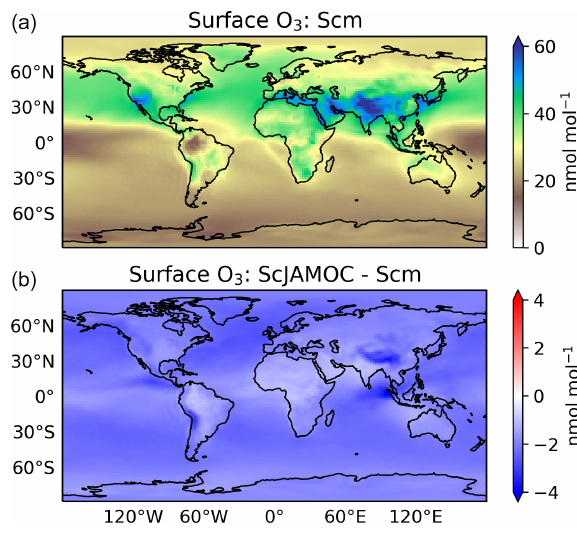
Figure 9. Mean surface O 3 mixing ratios for Scm (a) and in com- parison to ScJAMOC (b) . The characteristics of each simulation are provided in Table 1.